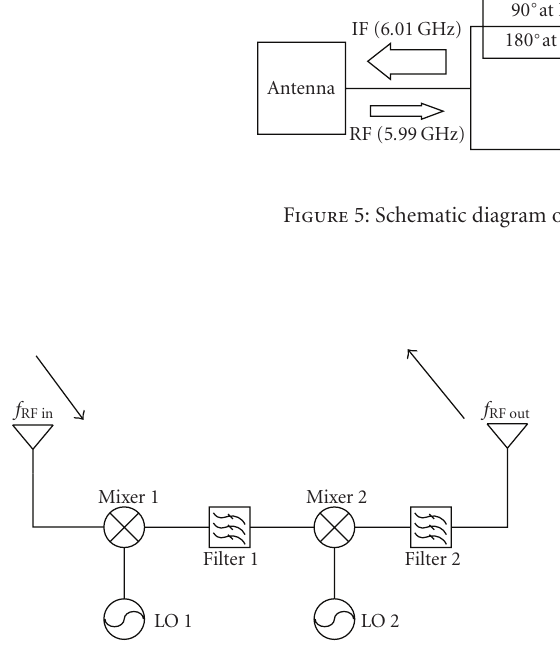
Figure 6: The schematic of heterodyne technique using an IF.